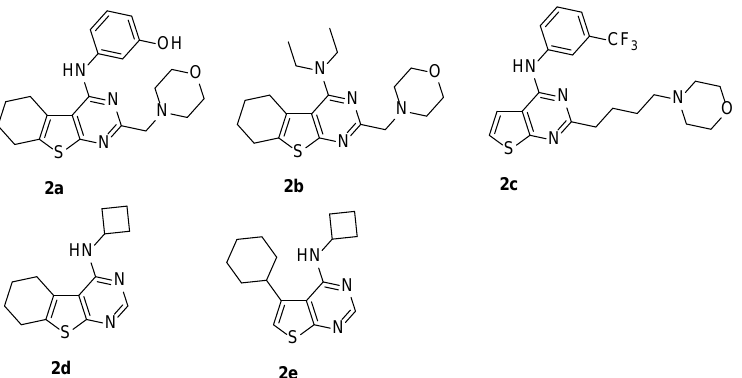
Figure 3. Derivatives of allosteric modulator 2— directions of modifications.